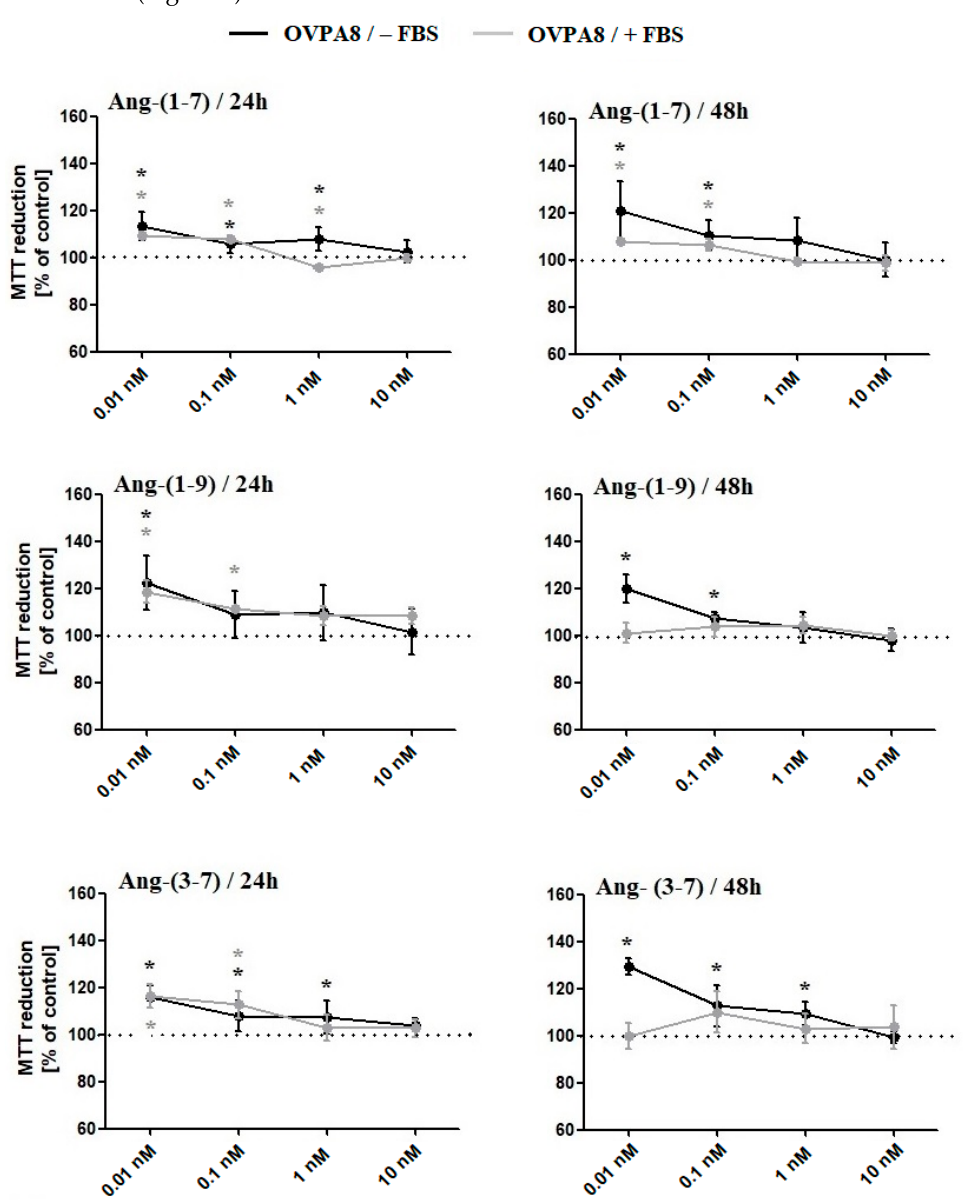
Figure 1. The MTT Assay results following the incubation of OVPA8 cells with tested angiotensins in the medium with or without FBS (mean ± SD; one-way ANOVA with Tukey’s test: * p < 0.05).